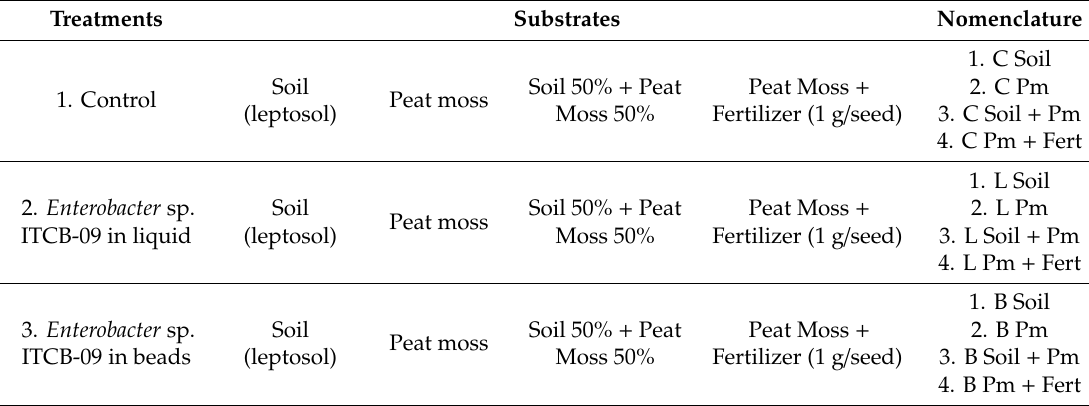
Table 1. Treatments and substrates used for the inoculation of Enterobacter sp. ITCB-09 on Habanero pepper ( Capsicum chinense